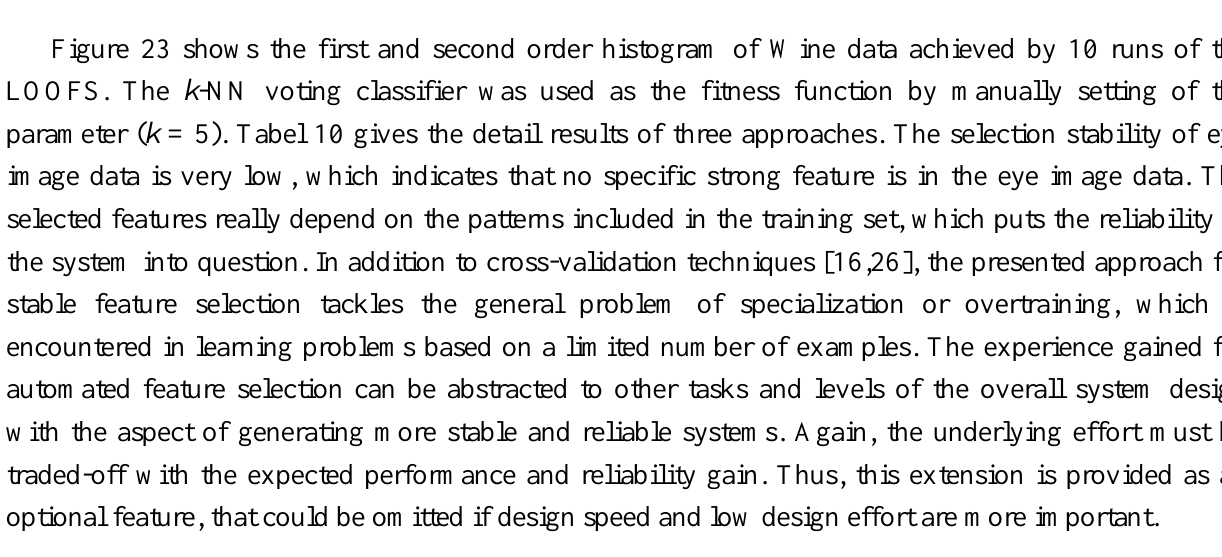
Figure 23. First and second order statistics of Wine